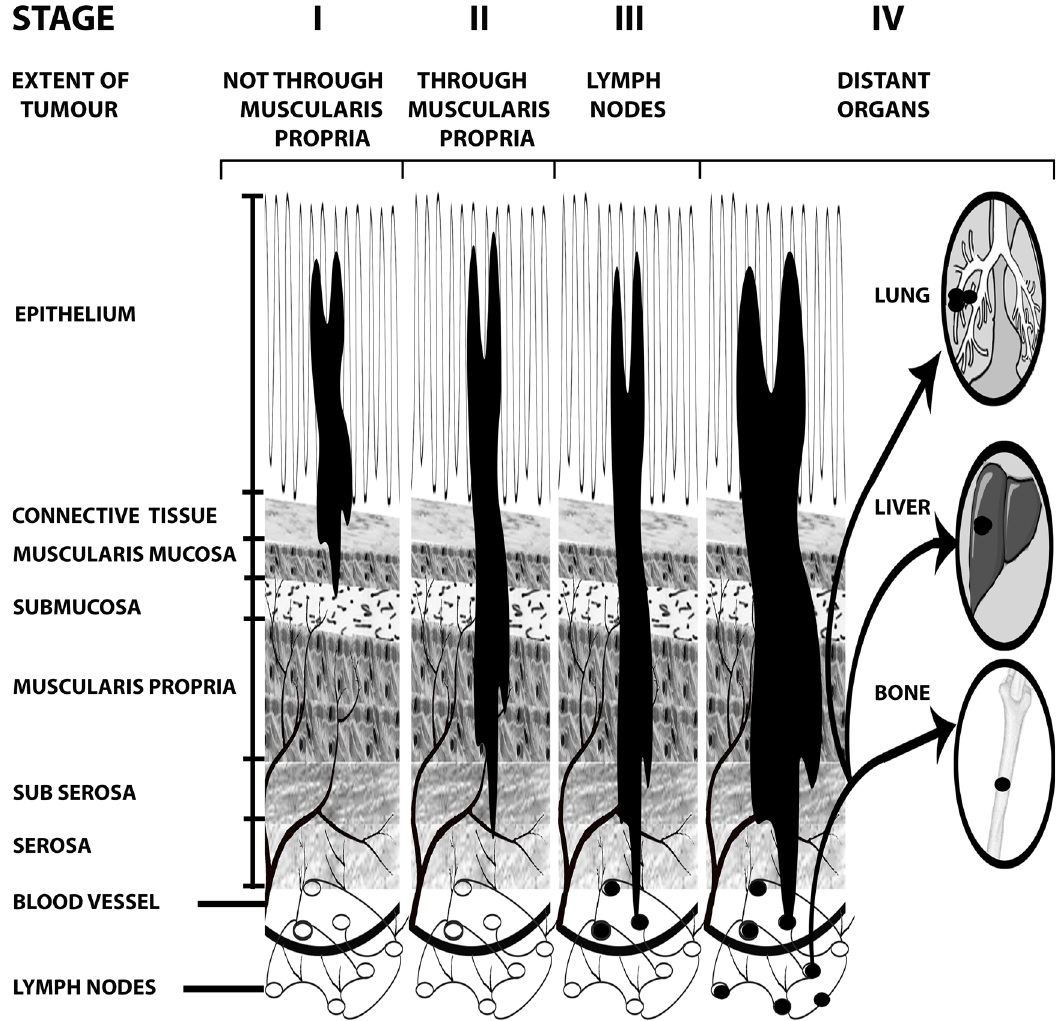
Fig 1. Staging of colon cancer. The American Joint Committee on Cancer (AJCC) has staged the colorectal cancer based on the anatomical extent of the disease. Stage I: Tumor that is limited to the mucosal layer (T1) or muscularis propria (T2), without involvement of any lymph node or distant metastatic organs. Stage II: Tumor that penetrates the muscularis propria (T3) or invades nearby organs or structures (T4), without involvement of any lymph node or distant metastatic organs. Stage III: Tumor stages with lymph node metastasis but without distant metastasis. Stage IV: Any tumor stage and lymph node status with distant organ